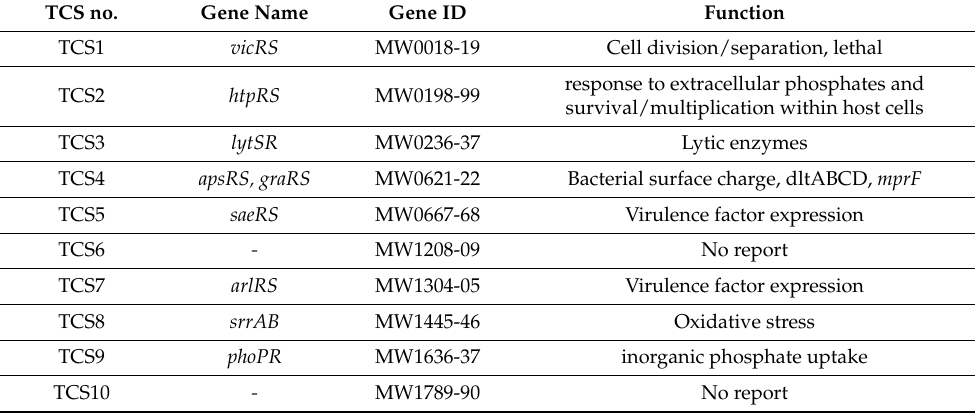
Table 1. Function of two-component system in Staphylococcus aureus MW2